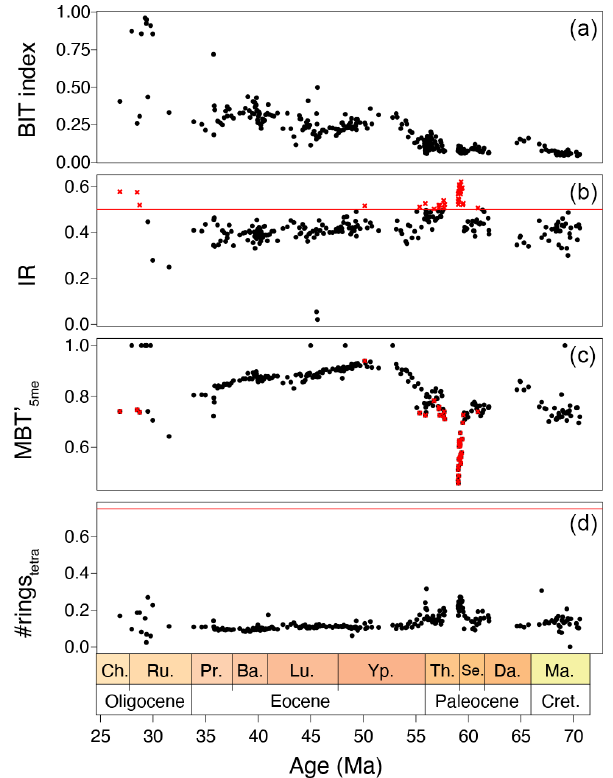
Figure 7. (a) BIT index, (b) IR (with cutoff value of the Aus- tralian soil IR of 0.5 and discarded MAAT samples in red crosses), (c) MBT’ 5me and (d) #rings tetra from Site